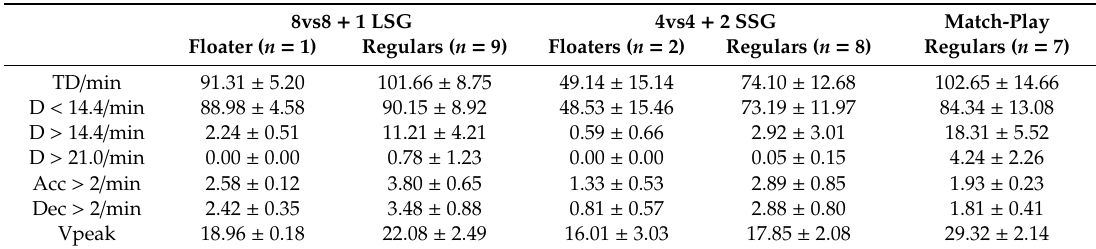
Table 3. Descriptive results in the physical demands encountered by floaters and regular soccer players during the 8vs8 + 1 LSG, the 4vs4 + 2 SSG and match-play. 8vs8 + 1 LSG